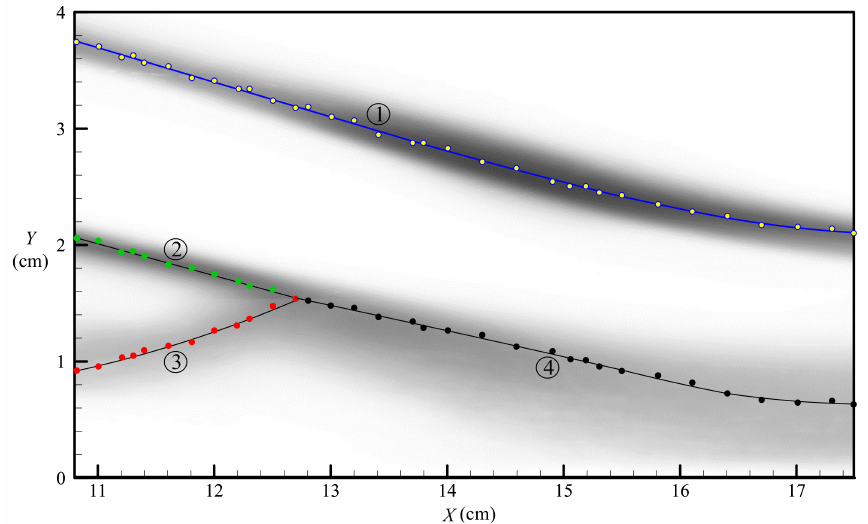
Figure 12. Spatial variation of the ensemble-averaged gray level distribution using 9000 SIM images, together with display of the three water–air interfaces (marked with 1 (cid:13) – 3 (cid:13) ) and the virtual boundary (labeled with 4 (cid:13)